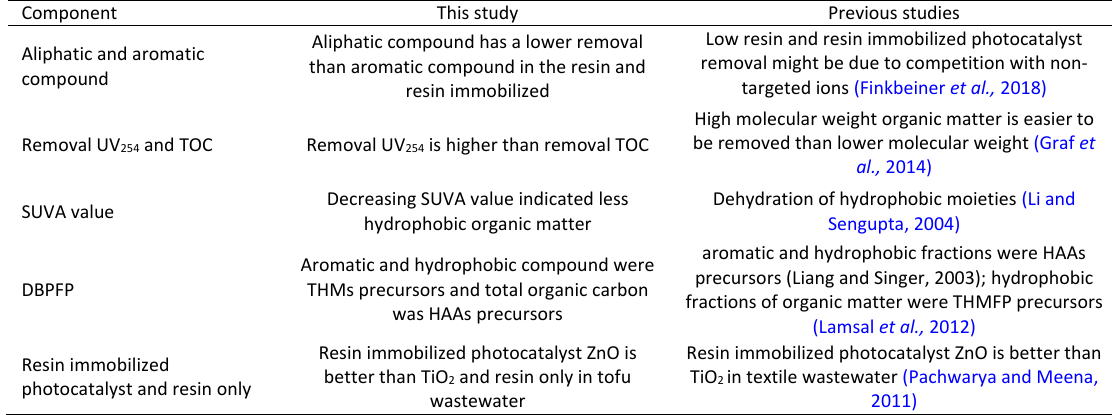
Table 1: Resumed of comparison between this study and the previous study regarding the characteristic of dissolved organic matters through resin ion exchange and resin immobilized photocatalyst